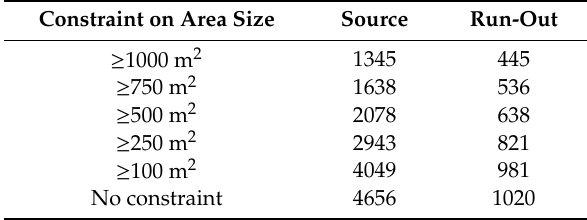
Table 4. Numbers of extracted source and run-out samples with di ff erent area